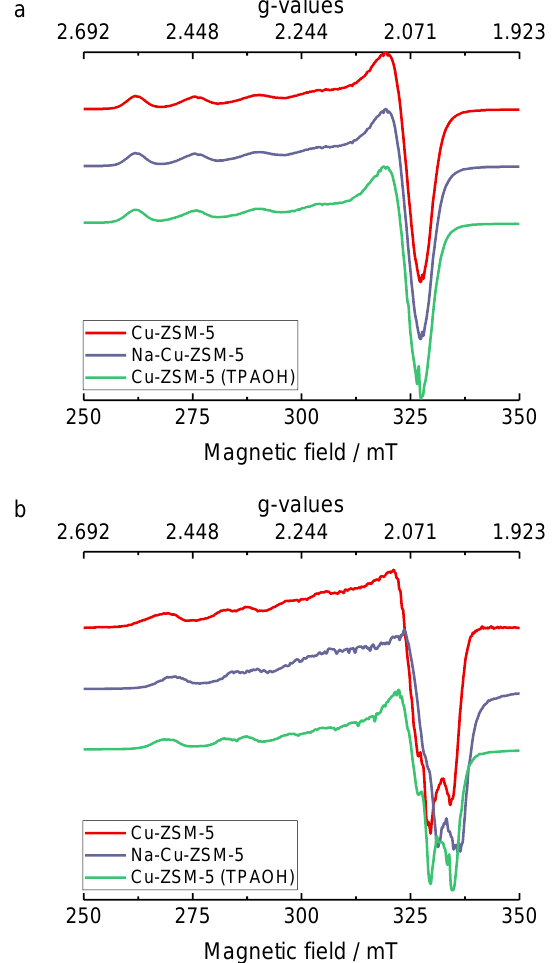
Figure 8. EPR spectra of: ( a ) hydrated (calcined at 500 ◦ C, 4 h, air) and ( b ) dehydrated Cu-exchanged ZSM-5 recorded at − 196 ◦ C. The complete dehydration was achieved at 200 ◦ C for 1 h in dynamic Fig. 8: EPR spectra of: a) hydrated (calcined at 500  C, 4 h, air) and b) dehydrated Cu- vacuum reaching a final pressure of 10 − 3 exchanged ZSM-5 recorded at -196  C. The complete dehydration was achieved at 200  C for 1 h in dynamic vacuum reaching a final pressure of 10 -3 mbar.